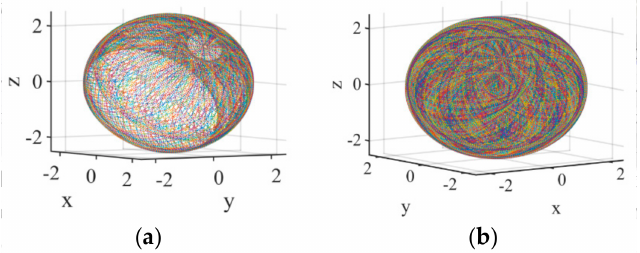
Figure 4. Simulation diagram of the motion trajectories. ( a ) Combination 1; ( b ) Total combination.